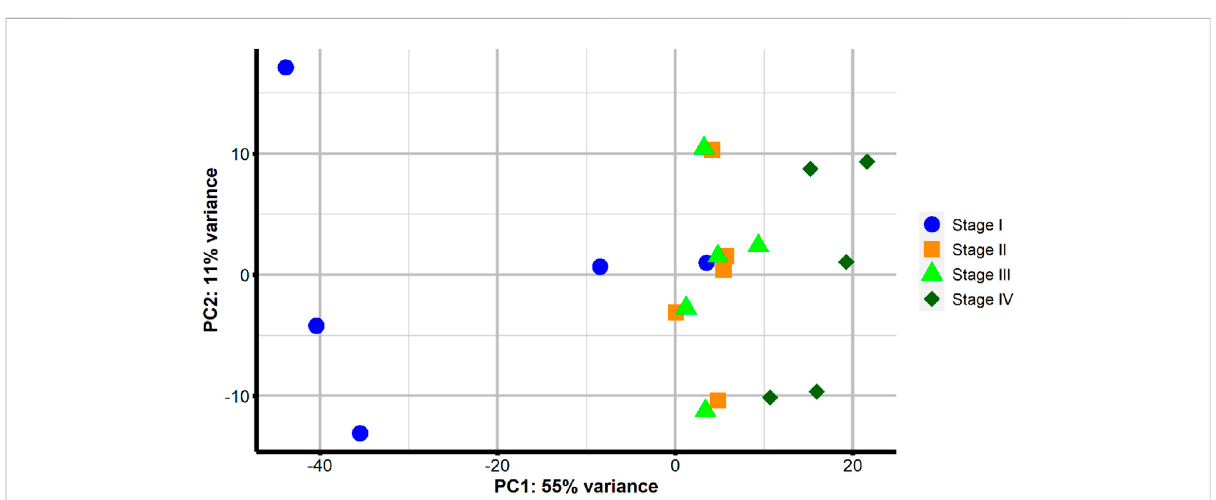
FIGURE 3 Principal component analysis of sample-to-sample Euclidean distances following VST transformation of gene counts in samples from four pointsofsampling: atprevitellogenicarrestedgonadal developmentbeforerGth treatment (StageI – bluecircle); atearly-to-mid-vitellogenesisafter 4 weeks of rFsh treatment (Stage II – orange square); at late-vitellogenesis obtained after the combination of rFsh and rLh (Stage III – light green triangle); and full-grown oocytes after the application of rLh to induce the latest stages of oocyte growth (Stage IV – dark green